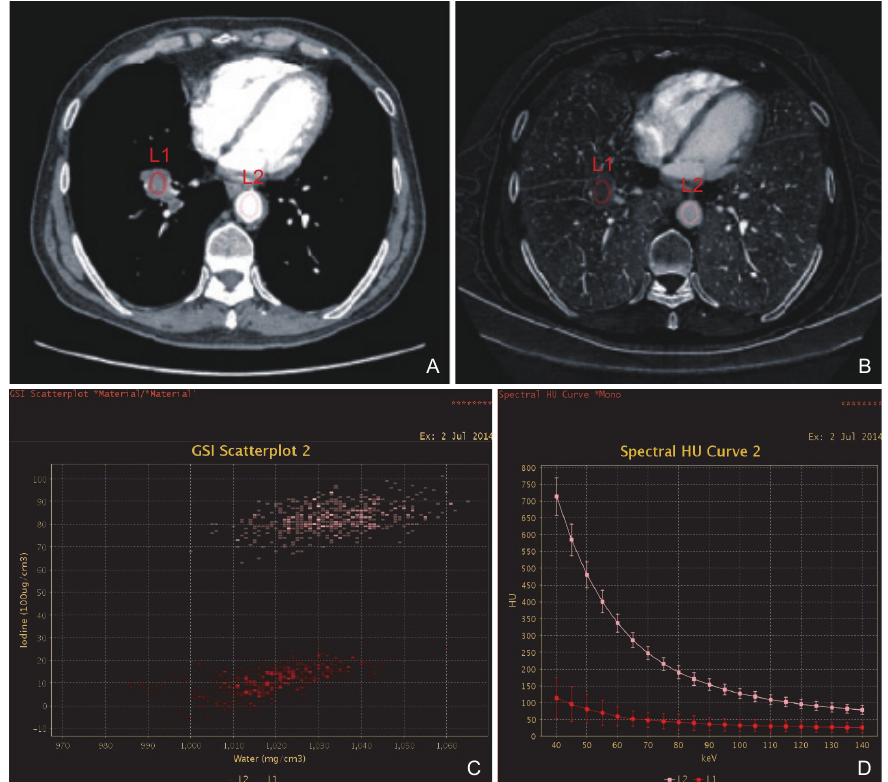
Figure 1 Axial monochromatic CT image (A) and iodine-based material decomposition image (B) of a 72-year-old man diagnosed with peripheral SqCC measuring 2.5 cm in the right lower lobe of the lung. L1 and L2 represented the measurements of iodine concentration of tumor (maximum IC les = 32 mg/mL) and descending aorta (IC ao = 140 mg/mL). NIC max then was calculated as 0.23 for this tumor.